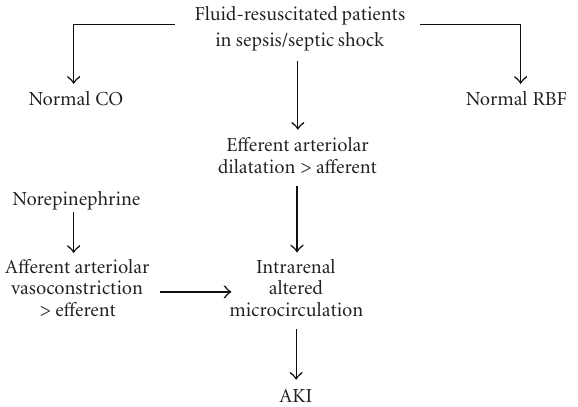
Figure 2: Hemodynamic alteration in fluid-resuscitated sepsis patients (see text for